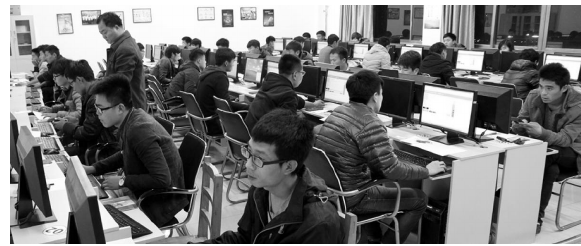
Fig. 1. Development of Higher Vocational Colleges in China.